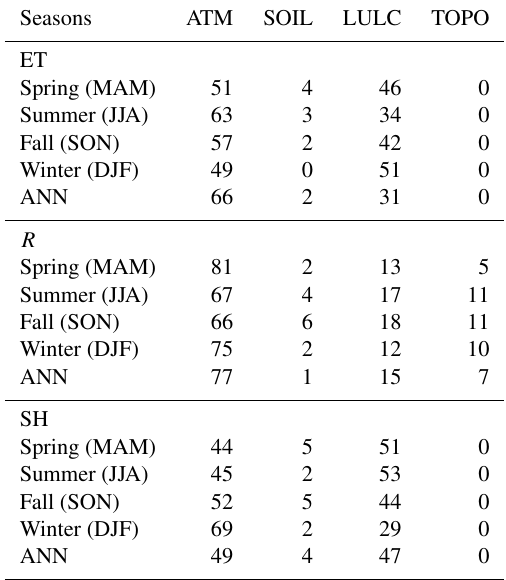
Table 4. Grid percentage of the dominant heterogeneity source in determining the spatial variability of ET, R , and SH for four seasons and annual mean